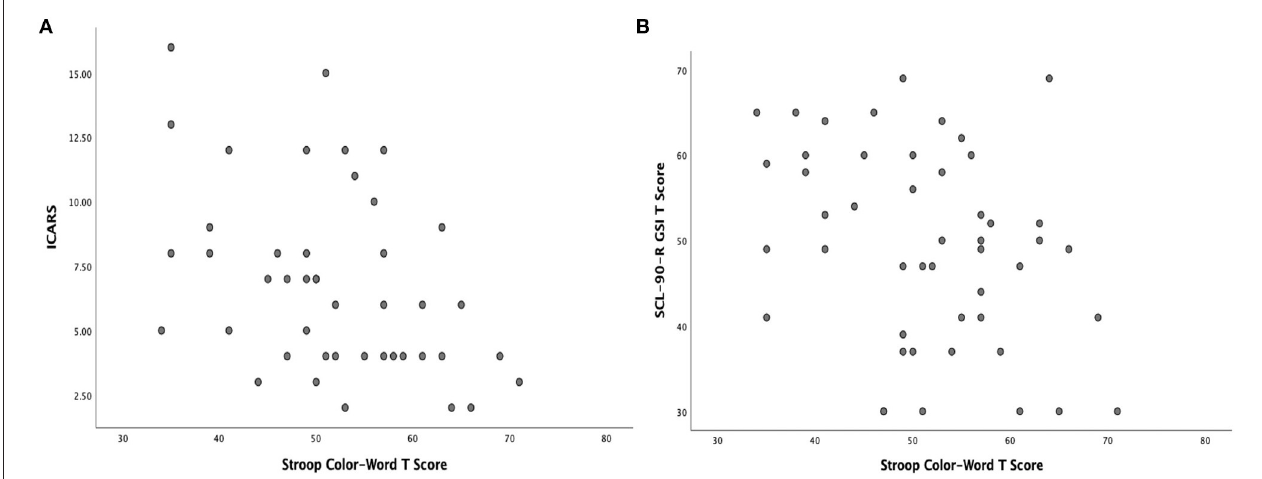
FIGURE 1 | (A) Scatterplots illustrating significant relationship between Stroop Color-Word t-score and ICARS Total score and (B) Scatterplots illustrating a significant relationship between Stroop Color-Word t-score and SCL-90-R Global Severity Index (GSI) t-score.